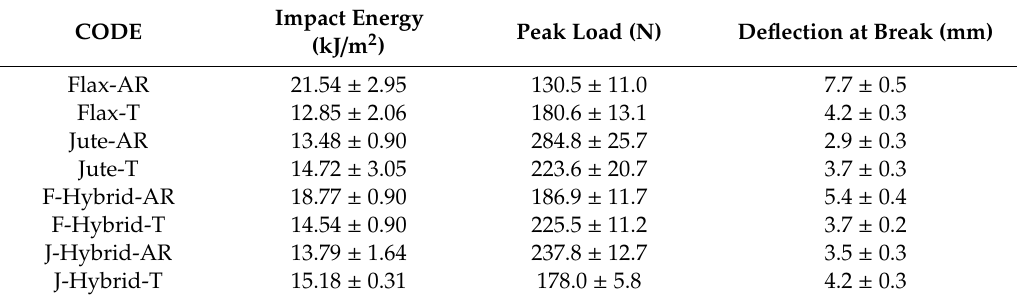
Table 3. Impact properties of laminates.